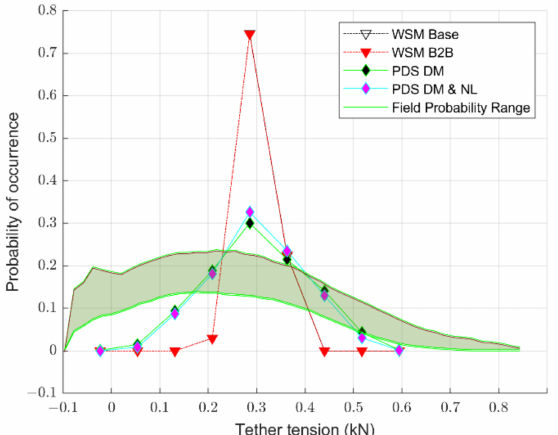
Figure 9. WEBS wave reconstruction tether tension probability of occurrence.